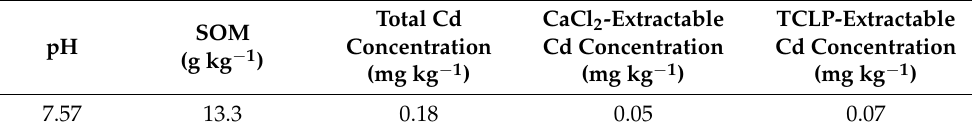
Table 1. The physicochemical properties of the